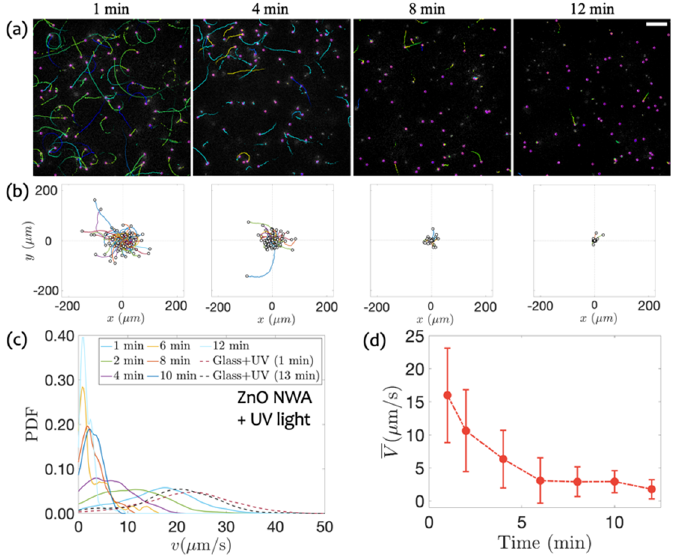
Figure 3. Bacterial swimming under UV irradiation on ZnO NWA. ( a , b ) Typical trajectories of swimming bacteria on NWA with varying time. ( c , d ) Speed distribution and mean speed at different time duration, respectively. A control experiment of bacteria swimming on bared glass under UV light is also plotted in ( c ). Scale bar is 30 μm .